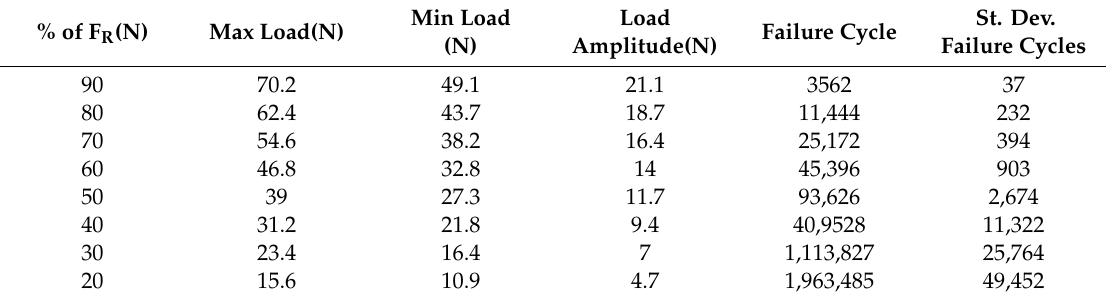
Table 2. Dynamic parameters of the fatigue tests of the TiO 2 / UHMWPE joints (1 wt% of TiO 2